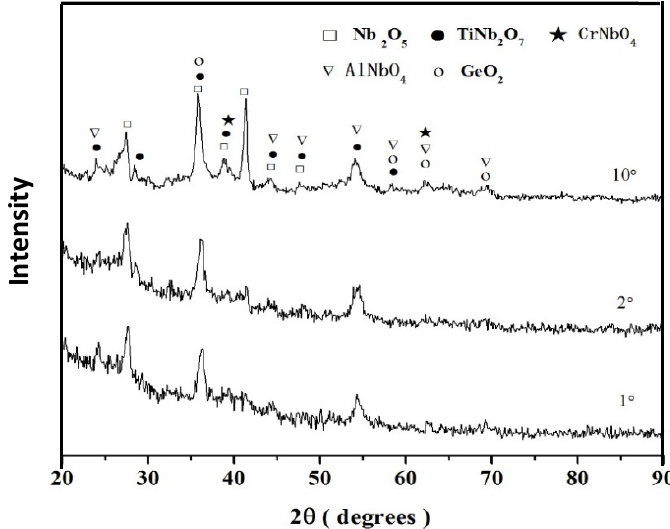
Materials 2019 , 12 , x FOR PEER REVIEW Figure 7. GXRD data ( γ = 1 ◦ , 2 ◦ , and 10 ◦ ) for the scale formed on the alloy ZF6 at 800 ◦ C in air. Figure 7. GXRD data (γ = 1 °, 2°, and 10°) for the scale formed on the alloy ZF6 at 800 °C in air.